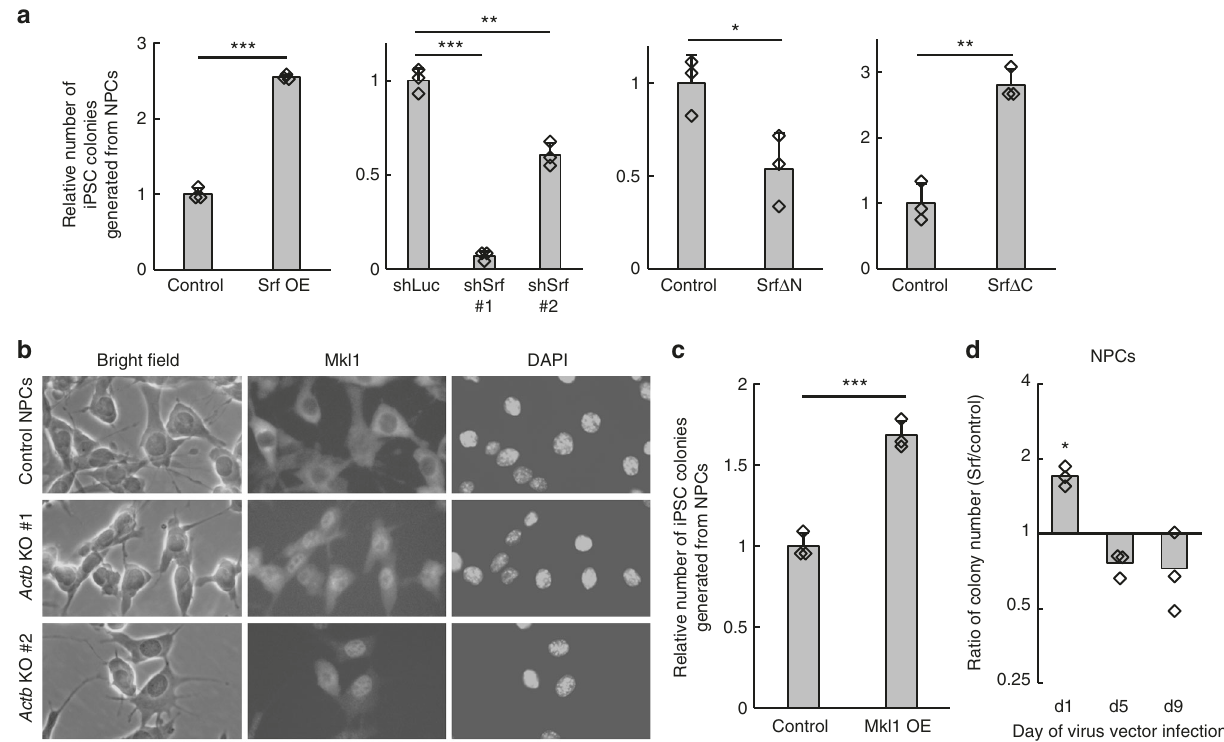
Fig. 3 Srf and its cofactor, Mkl1, promote reprogramming. a Srf promotes reprogramming. Values are means ± SD of the numbers of iPSC colonies produced relative to control cells ( n = 3). OE indicates overexpression. Dots indicate individual data points. Student ’ s t -test (*** P < 0.0005, ** P < 0.005, * P < 0.05). b Mkl1 mainly localizes in the nucleus upon β -actin depletion. Immuno fl uorescence microscopy of NPCs using anti-Mkl1 antibody and images of the corresponding bright fi eld and DAPI staining. Bar, 20 µ m. c Mkl1 promotes reprogramming. Values are means ± SD of numbers of iPSC colonies generated from NPCs relative to the control ( n = 3). Dots indicate individual data points. Student ’ s t -test (*** P < 0.0005). d Srf promotes reprogramming at early phase. NPCs were infected with egfp -expressing lentivirus or Srf -overexpressing lentivirus at the days indicated (d1 is the day of reprogramming initiation by Dox addition). Vertical axis shows the reprogramming ef fi ciency of Srf -overexpressing cells to egfp -expressing cells in logarithmic (log) scale ( n = 3). Dots indicate individual data points. Asterisks indicate statistically signi fi cant differences between Srf overexpression and control on the day of virus infection (Student ’ s t -test; * P <